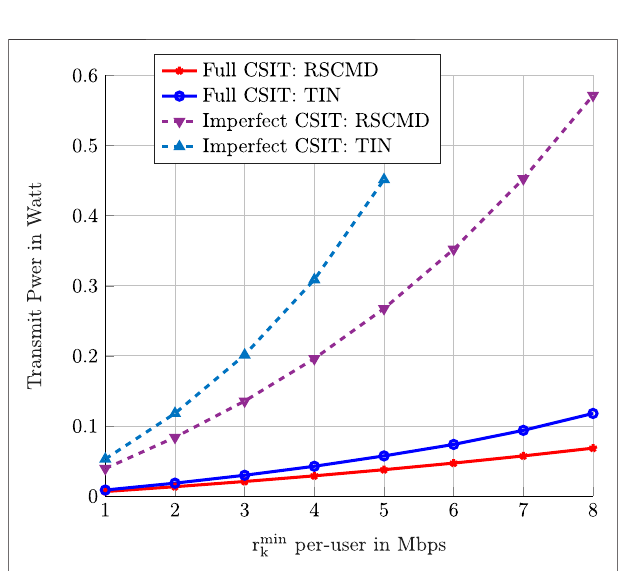
FIGURE 8 | Theoptimalvalueoftheoptimizationproblem(P 2 )asafunction oftheminimumergodicraterequestedbyusers.Wecomparetheperformanceof TIN and RS – CMD transmission strategies. Each BS has four